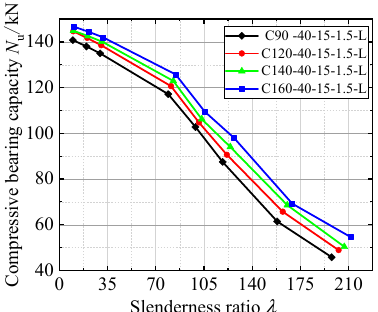
Figure 10. N u - λ relationship curves of the combined columns.